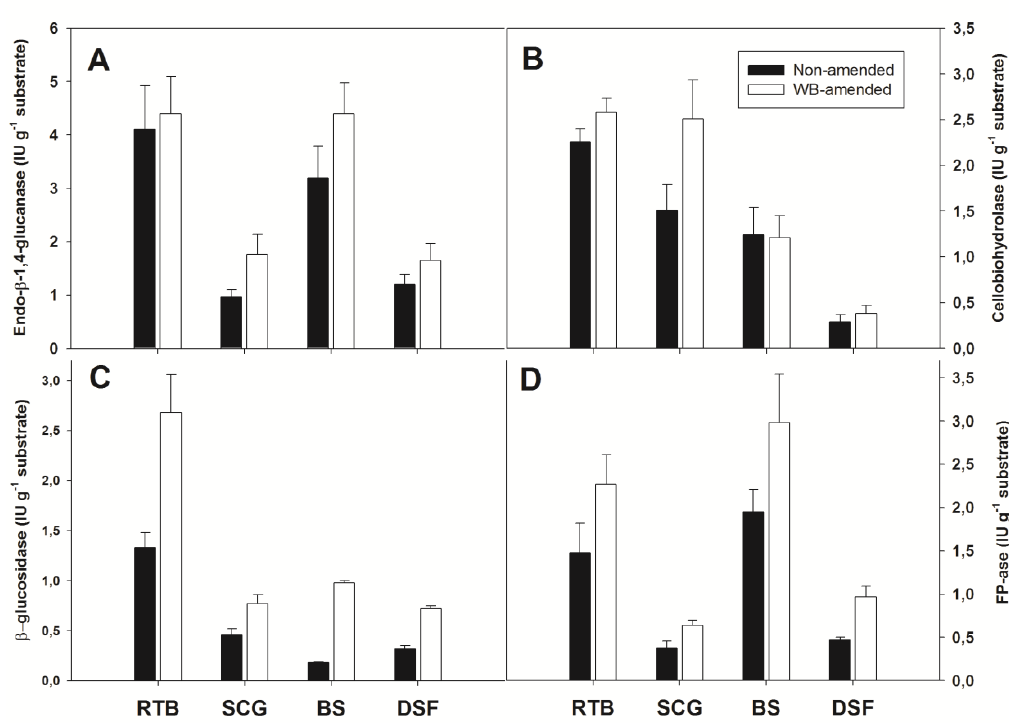
Figure 1. Specific activities, referred to unit mass of initial substrate, of endo- β -1,4-glucanase ( A ), cellobiohydrolase ( B ), β -glucosidase ( C ), and FP-ase ( D ) in 14-day-old solid-state cultures conducted on residual thistle biomass (RTB), spent coffee grounds (SCG), barley straw (BS) and digestate solid fraction (DSF) in the presence and in the absence of wheat bran (WB) as the amendment. Data are the mean ± standard deviation of four replicates.